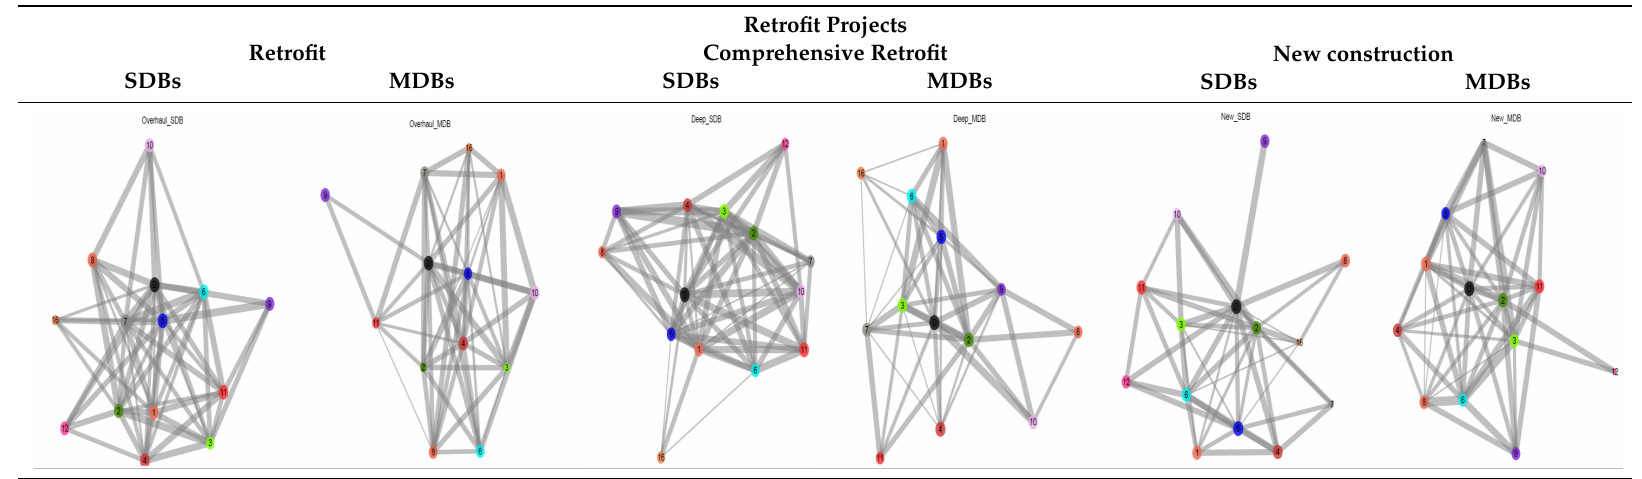
Table 6. Stakeholder level of power and interaction in the technology selection, classified according to building typologies and project types in Germany (DE).